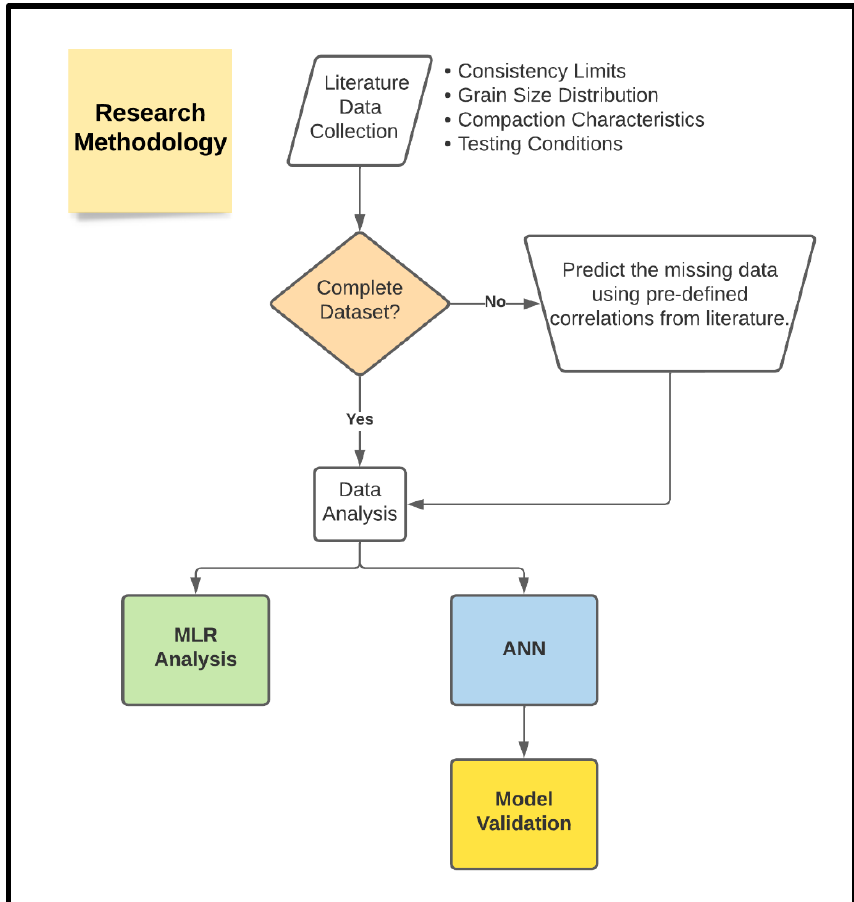
Figure 1. Research